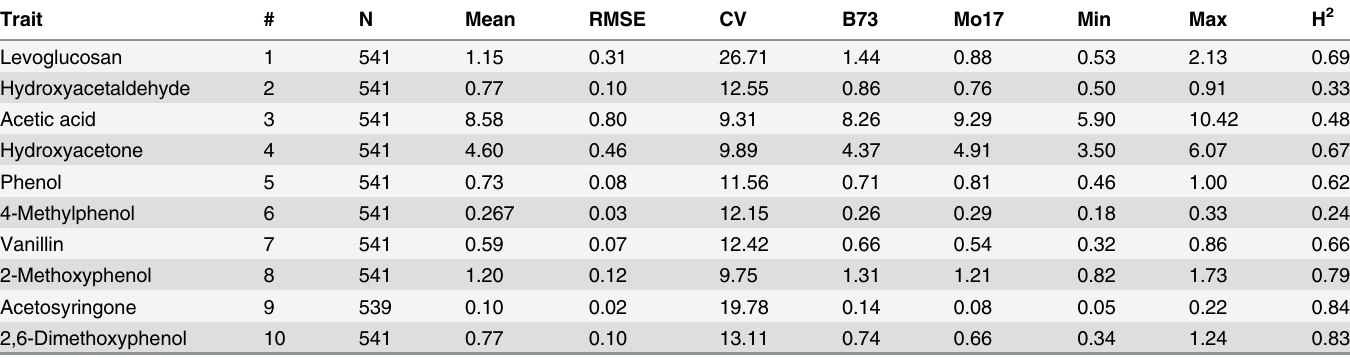
Values are given, by compound, for mean, square root of the mean square error (RMSE), coef fi cient of variation (CV), B73 and Mo17 lsmeans, minimum line lsmean, maximum line lsmean, and entry mean heritability (H 2